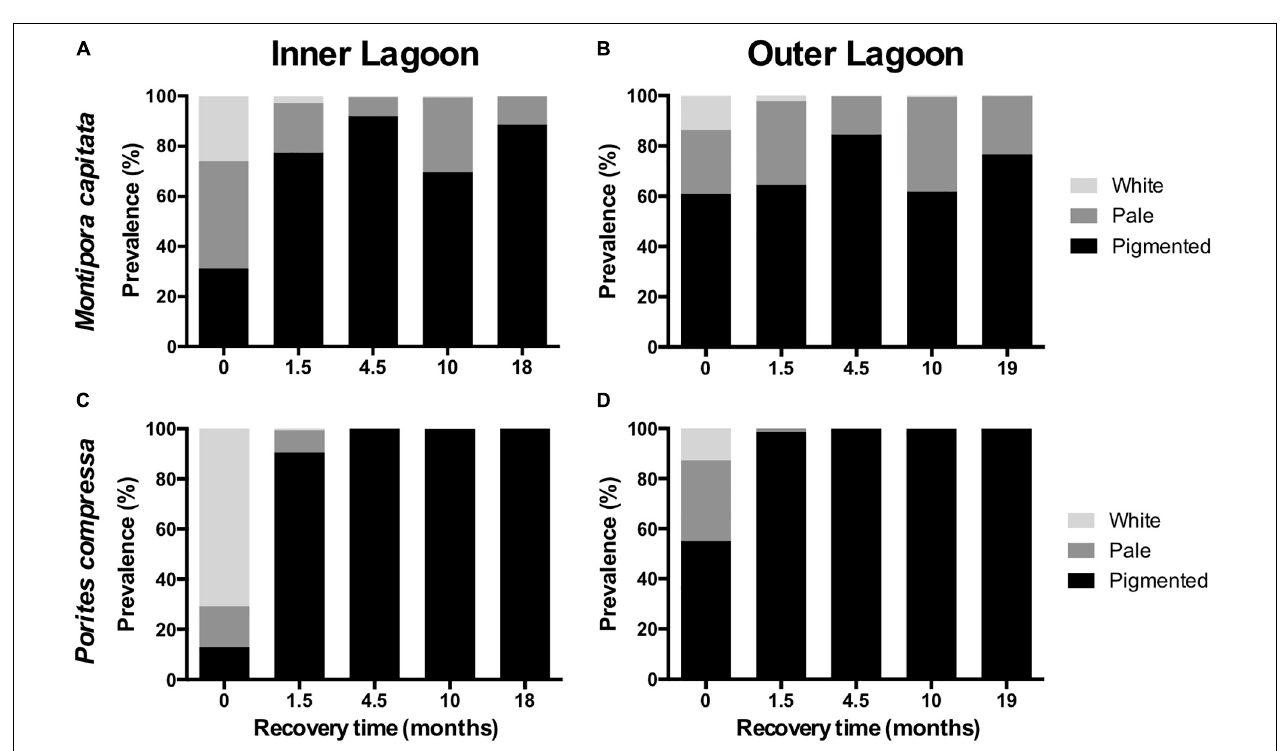
FIGURE 4 | Prevalence of coral bleaching from the peak of the bleaching event (Oct. 2015) and after 1.5, 4.5, 10, and 18–19 months of recovery for Montipora capitata (A,B) and Porites compressa (C,D) at the Inner lagoon (left column) and Outer lagoon (right column). Data represent the means of four replicate